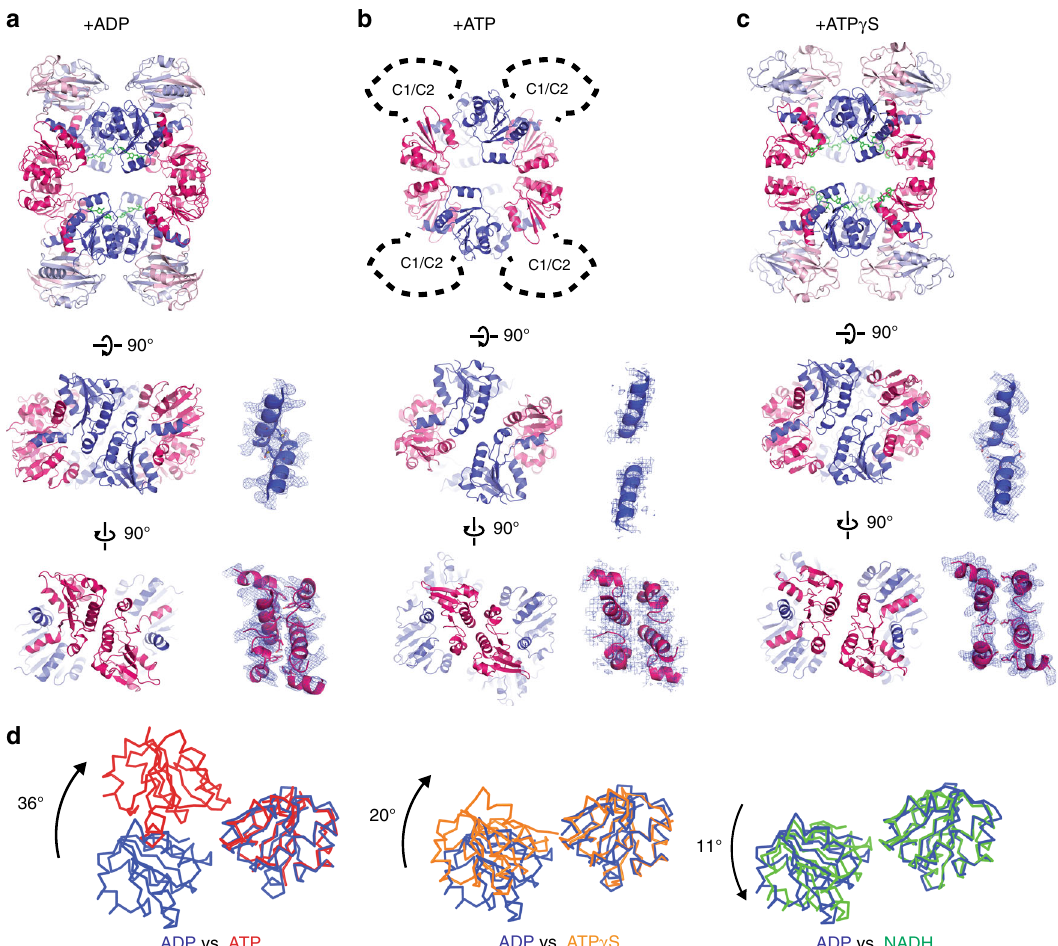
Fig. 2 Conformational changes in TrkA monomer and tetramer. a – c TrkA gating ring from TrkHA-ADP ( a ), TrkHA-ATP γ S ( b ), and TrkHA-ATP ( c ), viewed from the periplasmic (top), N2-N2 interface (middle), and N1-N1 interface (bottom) sides. The 2Fo-Fc electron density maps of N2-N2 and N1-N1 interfaces are shown as blue mesh contoured at 1.0 σ on the right. d Conformational changes within a TrkA protomer. N1 and N2 domains of a TrkA protomer from TrkHA-ADP (blue), TrkHA-ATP γ S (orange), TrkHA-ATP (red), or TrkHA-NADH (green) are render in ribbons. The N1 domains were superimposed to show the relative rotations of the N2